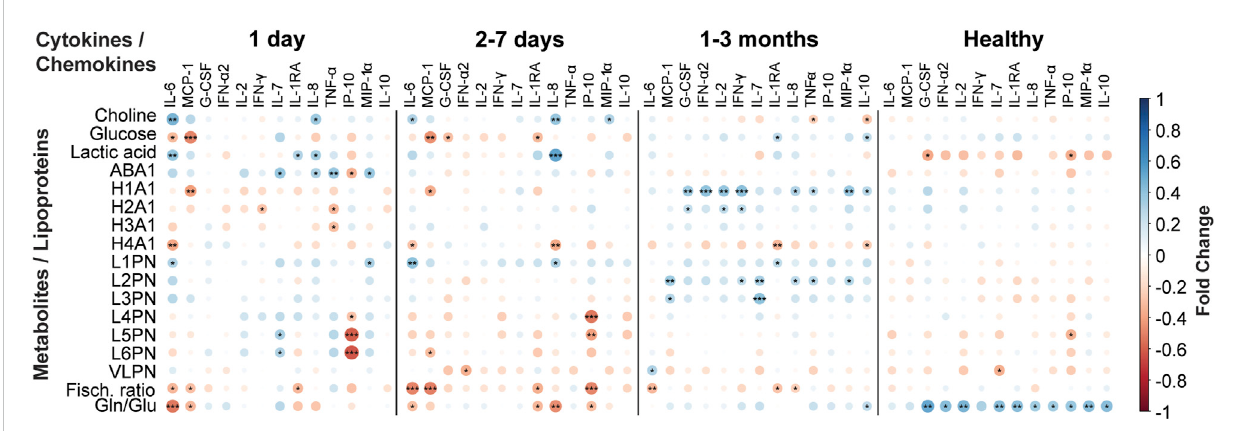
FIGURE 2 Immunometabolic correlation plots between a panel of cytokines/chemokines related with COVID-19 disease versus a set of metabolites and lipoproteins quanti fi ed in blood serum samples from COVID-19 patients. The plots represent the correlations from disease onset to up 3 months after infection. Negative correlations are coloured in red, while positive correlations are coloured in blue, as indicated in the fi gure legend. The calculations were performed in R.